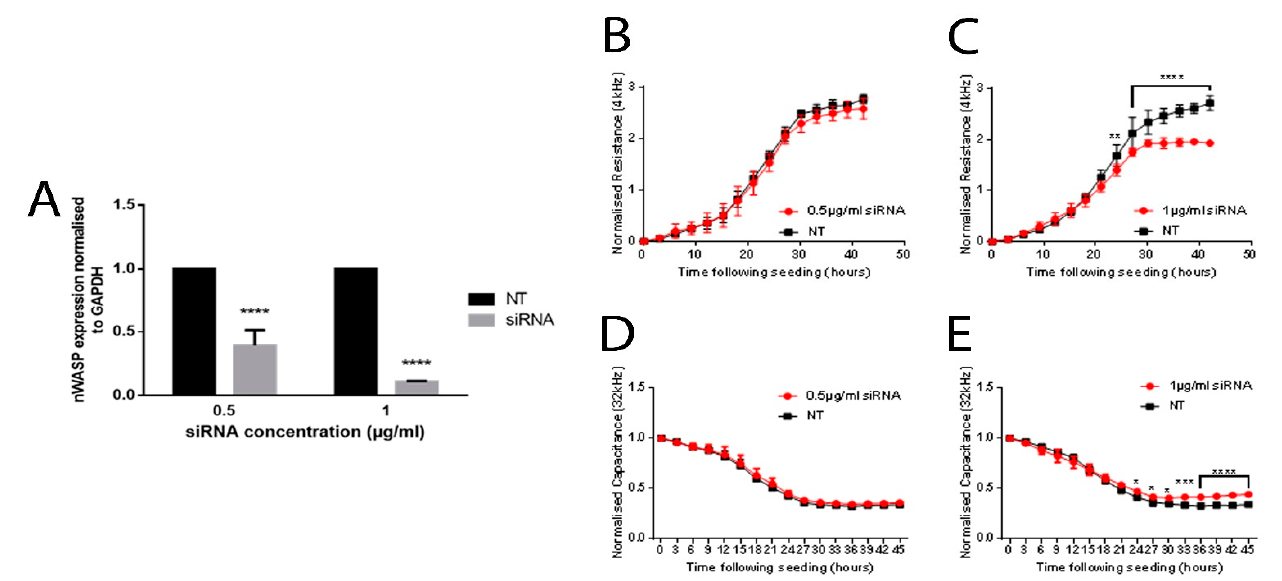
Figure 2. nWASP knockdown in the HaCaT cells. qPCR and PCR analysis of nWASP transcript expression ( A ). ECIS analysis of nWASP knockdown HaCaT cells. HaCaT cells treated with nWASP siRNA ( B – E ). * indicates statistical significance (* p < 0.05, ** p < 0.01, *** p < 0.001 **** p < 0.0001).